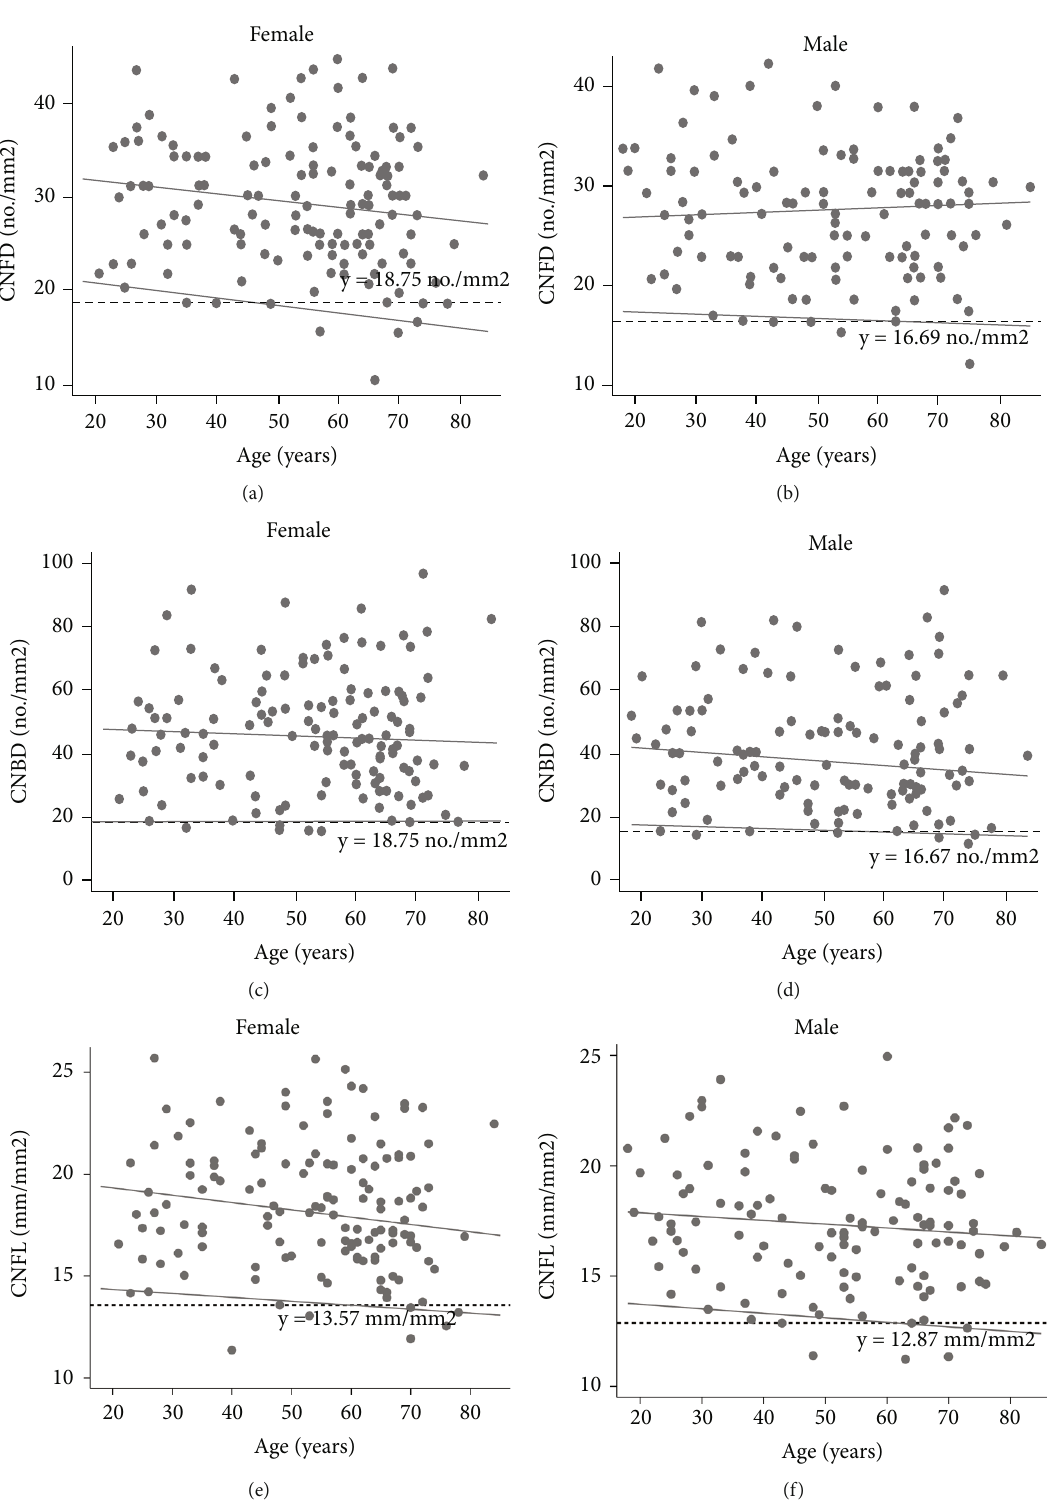
Figure 2: Scatterplot showing corneal nerve parameter values in 257 healthy volunteers strati fi ed by sex (120 males, 137 females). (a) CNFD for female. (b) CNFD for male. (c) CNBD for female. (d) CNBD for male. (e) CNFL for female. (f) CNFL for male. Black continuous lines describe the 5 th and 50 th quantile regression lines. Red dotted lines represent reference values for corneal nerve parameters we